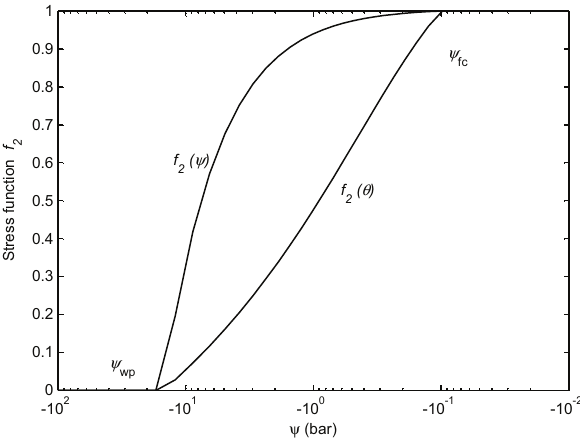
Fig. 13. The functions f 2 ( θ ) and f 2 ( ψ ) as related to soil matric pressure.